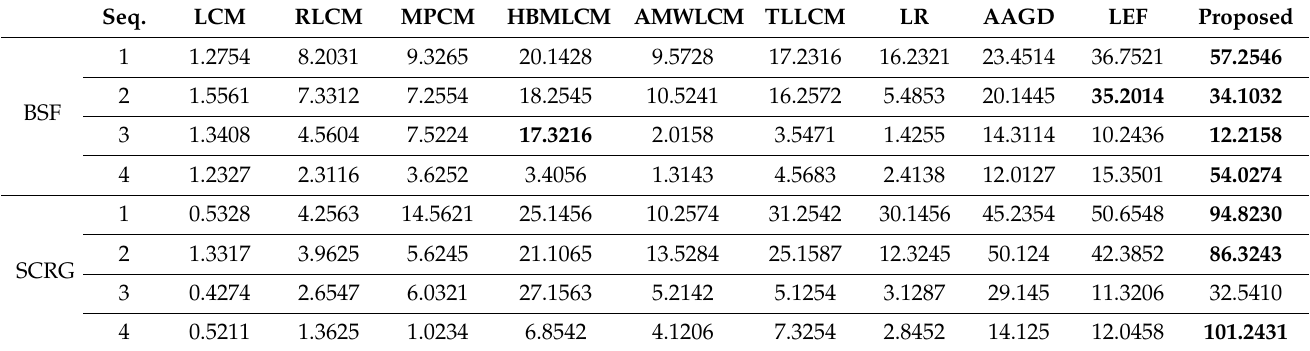
Table 2. BSF and SCRG of different